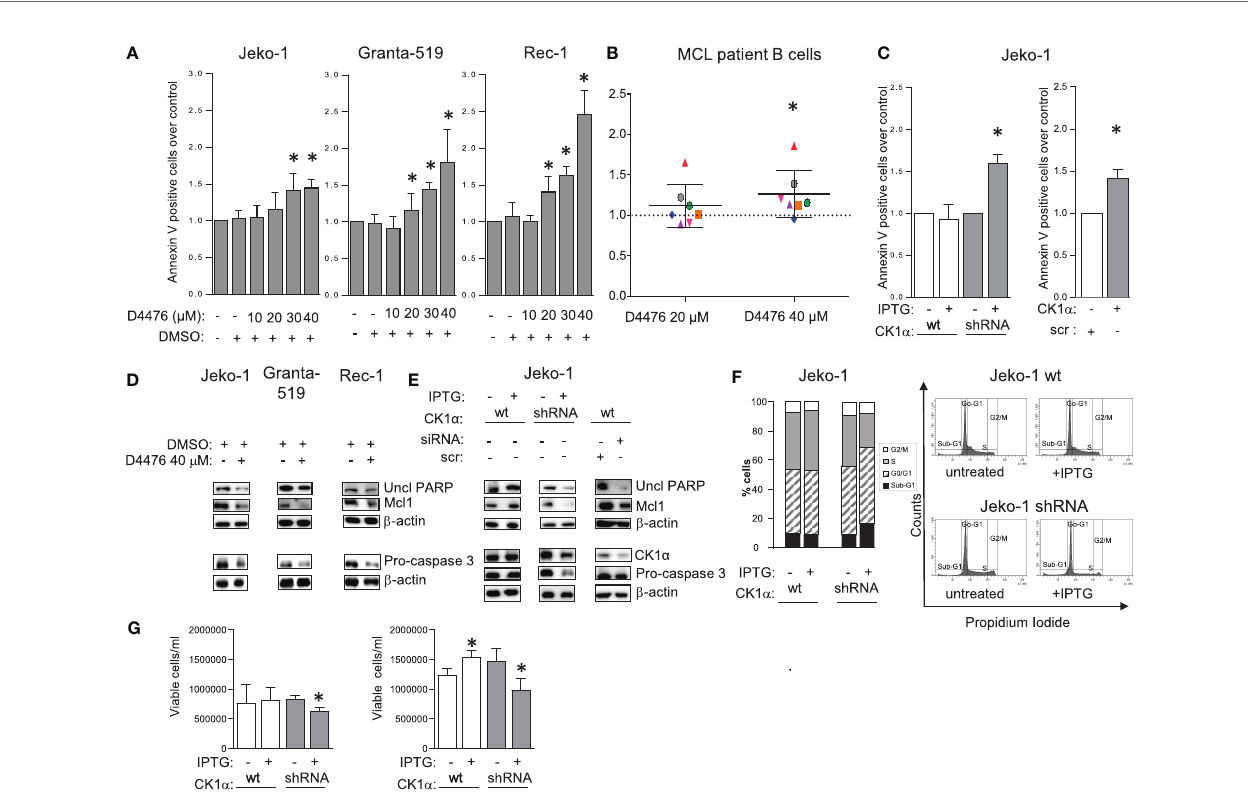
FIGURE 2 | CK1 a sustains MCL cell survival and proliferation. Histogram showing annexin V positive cells of MCL cell lines Jeko-1 Granta-519 and Rec-1 (A) , 7 independent MCL patients B cells (B) treated with different concentration of D4476 for 48h (A) or 24h (B) , Jeko-1 IPTG inducible CSNK1A1 directed shRNA clone (named CK1 a shRNA) and Jeko-1 wt treated with IPTG 500µM for 13 days ( C left panel) or Jeko-1 cells electroporated with CSNK1A1 directed siRNAs for 48h ( C right panel). Data are expressed as mean ± SD of n=3 (A) , n=7 (B) n=4 ( C left panel) and n=3 ( C right panel) independent experiments. * indicates p < 0.05 compared to the untreated cell population. The silencing ef fi cacy and the expression of anti-apoptotic proteins are showed in (D, E) In WB panels, b -actin was used as loading control. Uncl PARP= Uncleaved PARP. (F) cell cycle distribution with PI staining and FACS analysis of the same cells as in (C) . Left: bar graph representing the average of four independent experiments of the sub-G1 (black), G0/G1 (striped, gray), S (grey) and G2/M (white) phases of the cell cycle. Right: representative FACS histogram plots. (G) Trypan blue negative (viable) Jeko-1 wt (white bars) and Jeko 1 shRNA cellular clone (grey bars) treated with IPTG 500µM for 6 days (left panel) or 13 days (right panel). Data are expressed as mean ± SD of n=3 experiments (wt and shRNA clone, left panel), n=4 experiments (wt Jeko-1 right panel) and n=8 experiments (Jeko-1 shRNA clone, right panel). * indicates p < 0.05 compared to the corresponding untreated cell